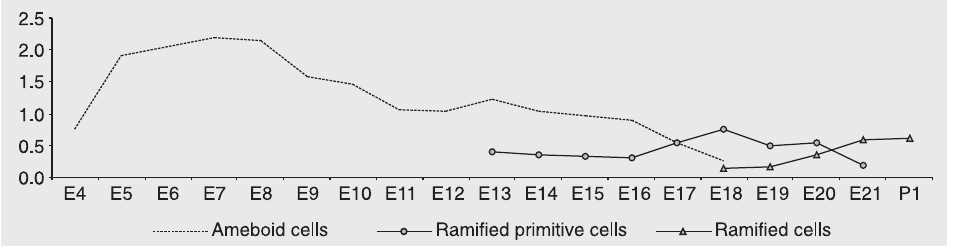
Figure 3. Ameboid, primitive ramified and ramified microglial cell percentage from embryonic day 4 (E4) to embryonic day 21 (E21) embryos and the first neo- natal day (P1)